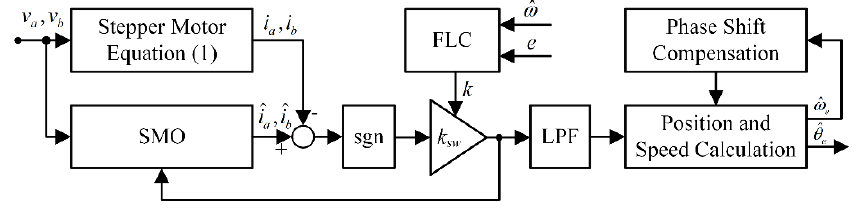
Figure 5. Block diagram of the fuzzy SMO.